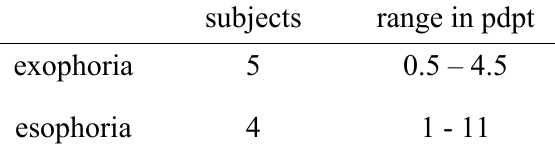
Table 4: Distribution of associated phoria